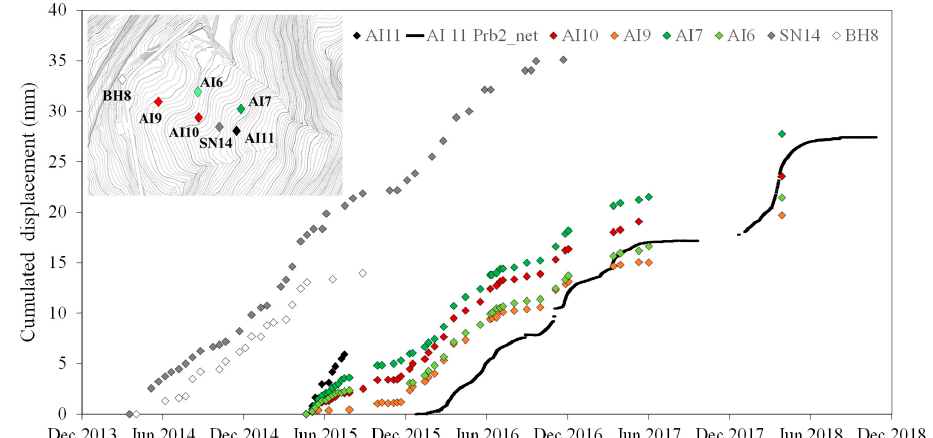
Figure 8. Cumulative displacement obtained by means of manual and in-place probes from 2014. The continuous graph represents the corrected cumulated displacement from in-place probes.